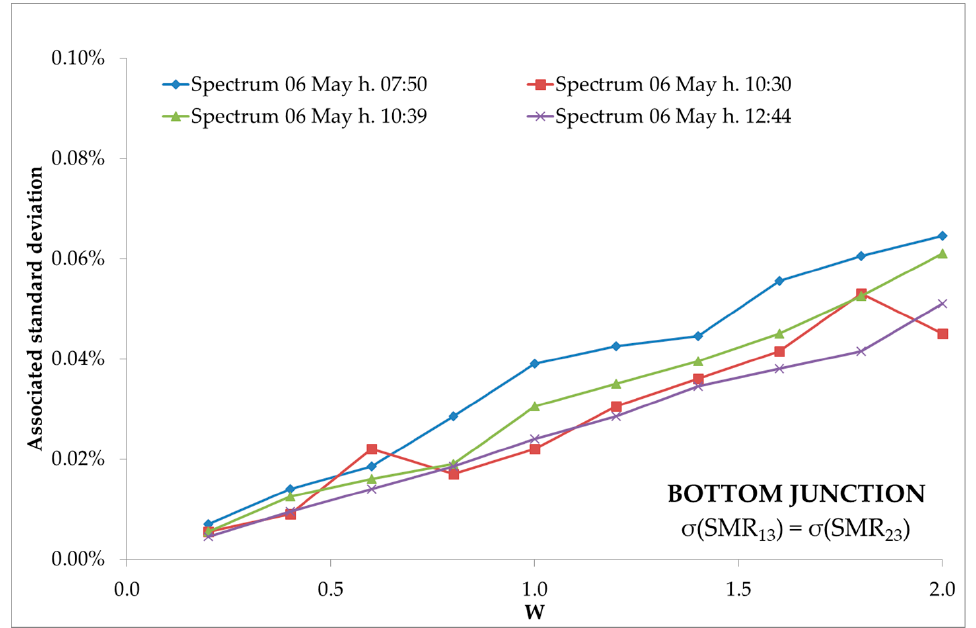
Figure 6. Impact of the errors on Bottom junction spectral responsivity on SMR 13 and SMR 23 (k = 1). The slope of the functions indicates how much the output error is sensitive to an accurate estimation of the input errors on the bottom junction spectral response.